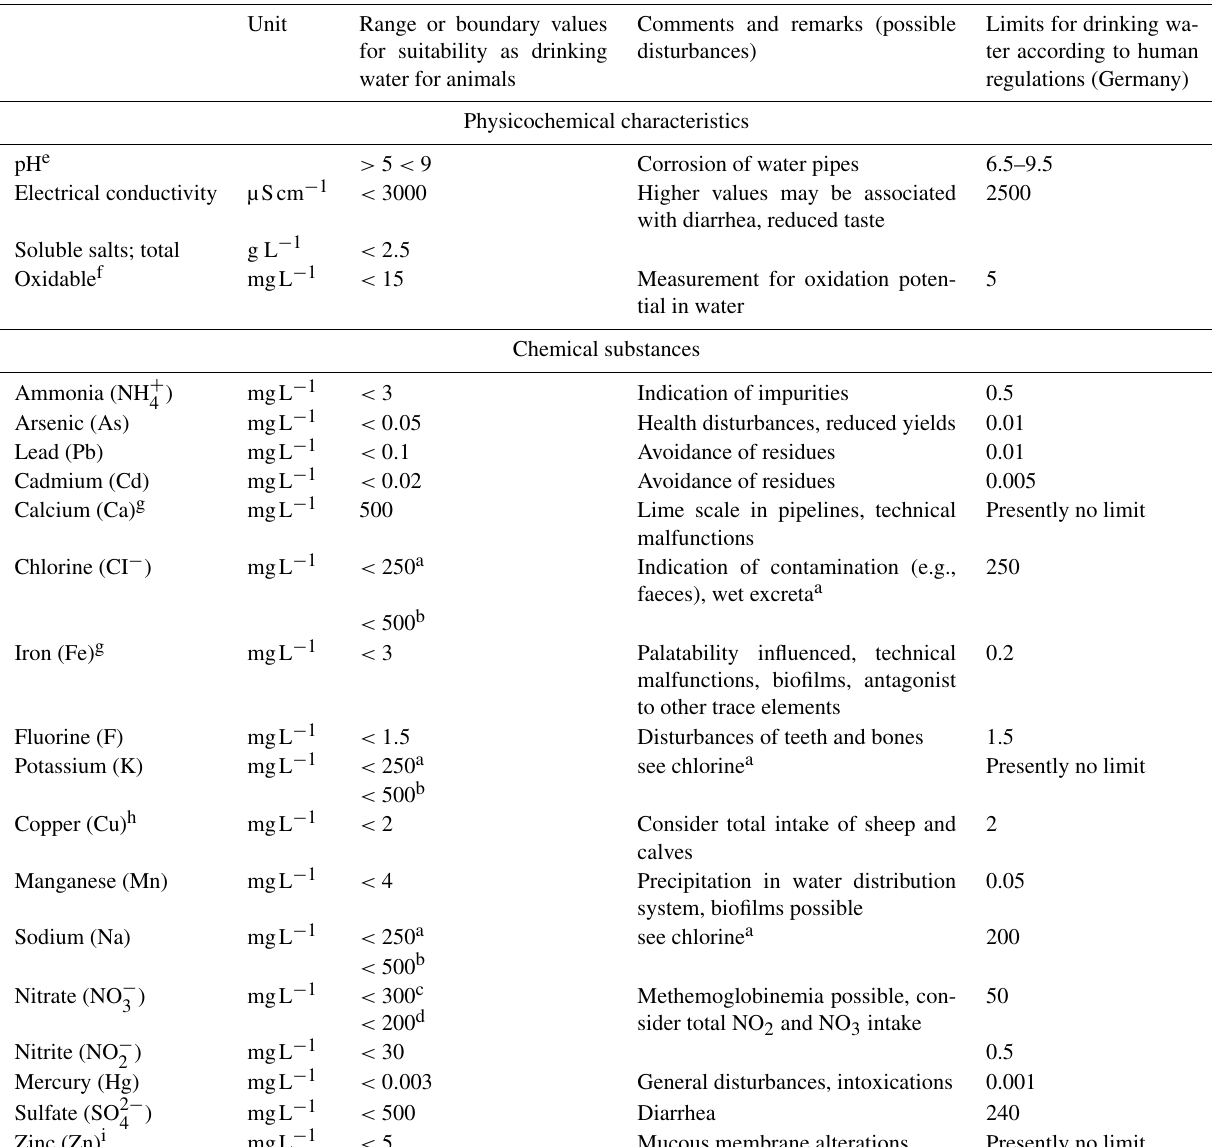
Table 4. Recommendations to assess chemical and physicochemical quality of drinking water according to feed and food safety (Kamphues et al.,